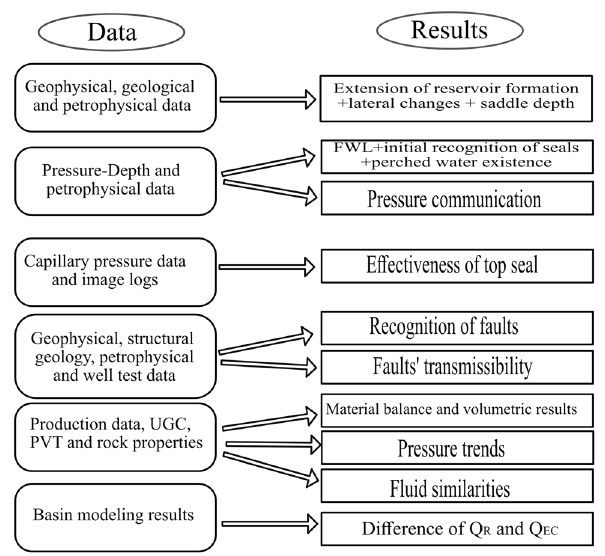
Fig. 1 Flowchart of the essential data and resulted information for confirmation of reservoir connectivity between adjacent fields